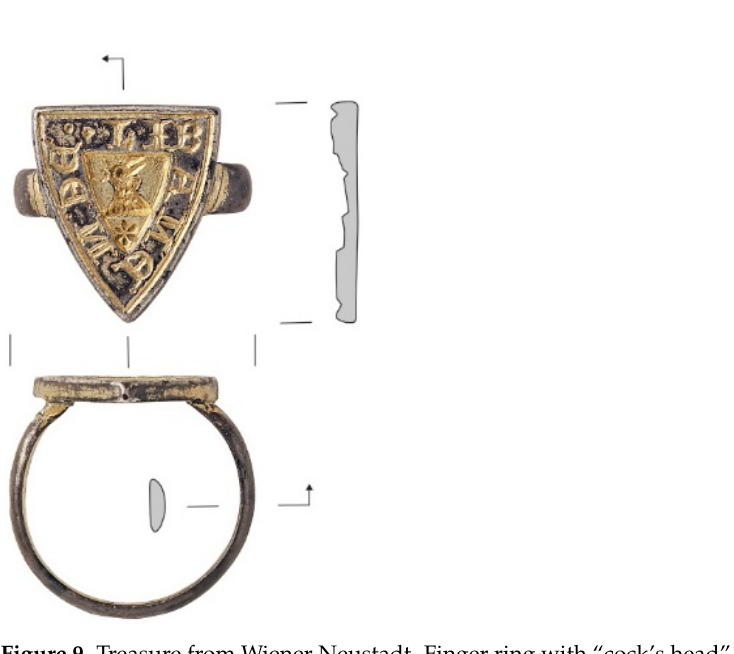
Figure 9. Treasure from Wiener Neustadt. Finger ring with “cock’s head” motif, 13th/14th century. Photo: Paul Kolp; editing: Franz Siegmeth.